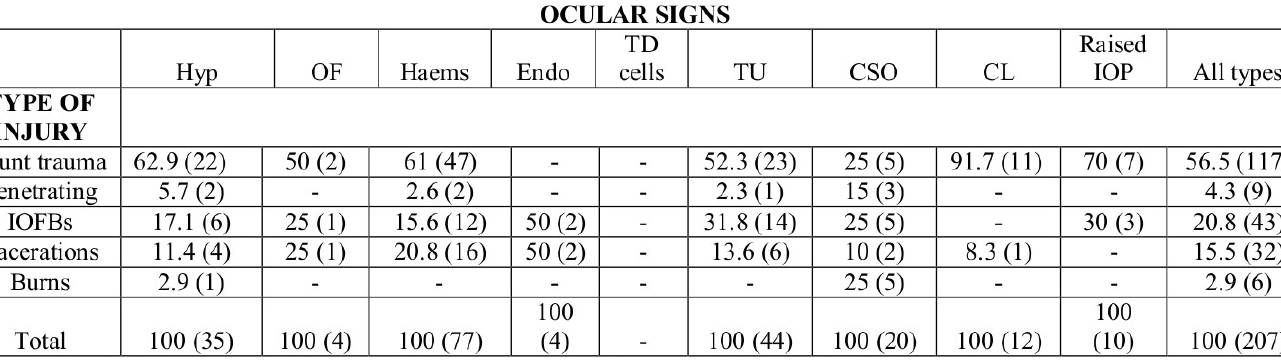
Table 1. Showing the type of injury in relation to associated ocular signs. In each column, both the percentage and number of injuries ( n ) in brackets are provided.